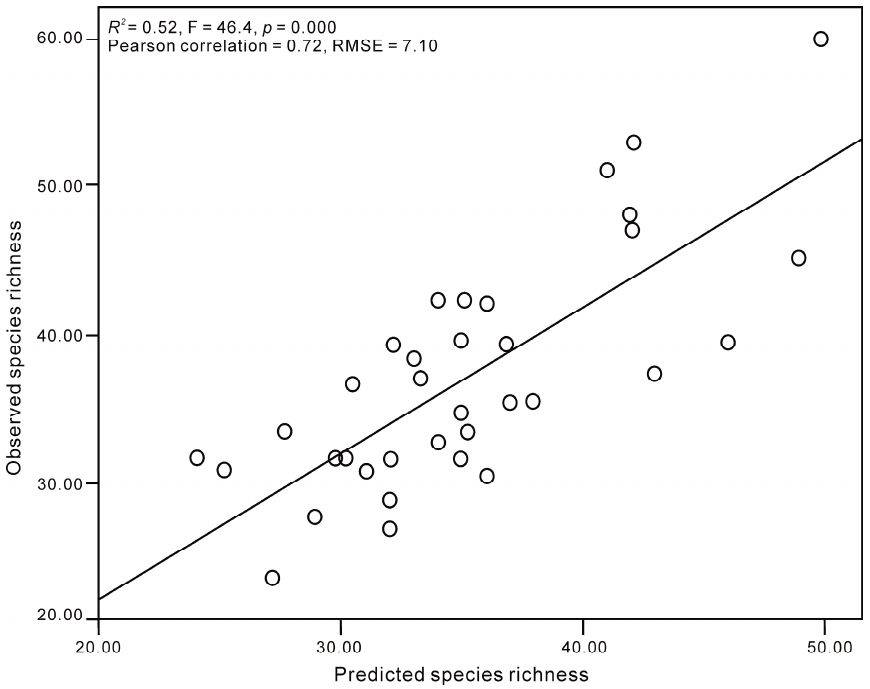
Figure 6. Relation between the observed species richness and the predicted species richness.